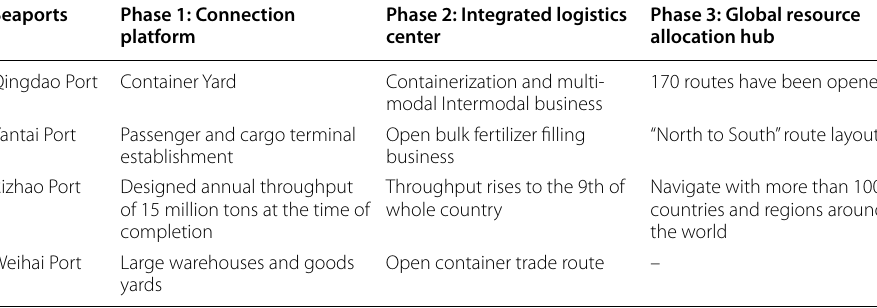
Table 4 Situation of each stage of port evolution in Shandong province Seaports Phase 1: Connection Phase 2: Integrated logistics platform